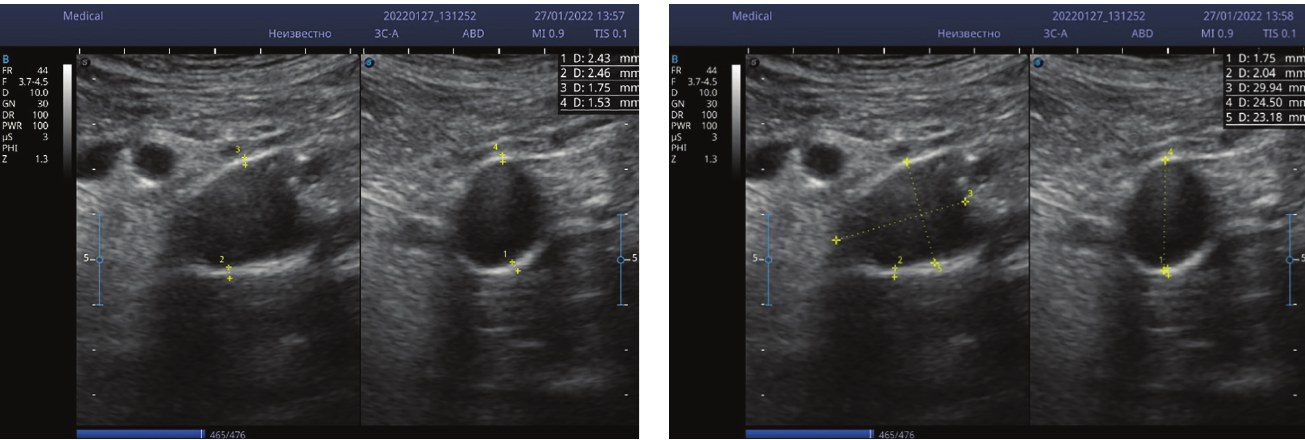
Figure 3 - Last US imaging of PDAA (January 2022): shows the calcified wall with up to ~2.46mm thickness and unchanged diameter of the aneurysm (D~29.94mm) compared to the size ~6 years ago (Figure 2). Note: Slight deviation in the size measurements on US and CT is acceptable, because of difficulty to get the same cut on the US as of